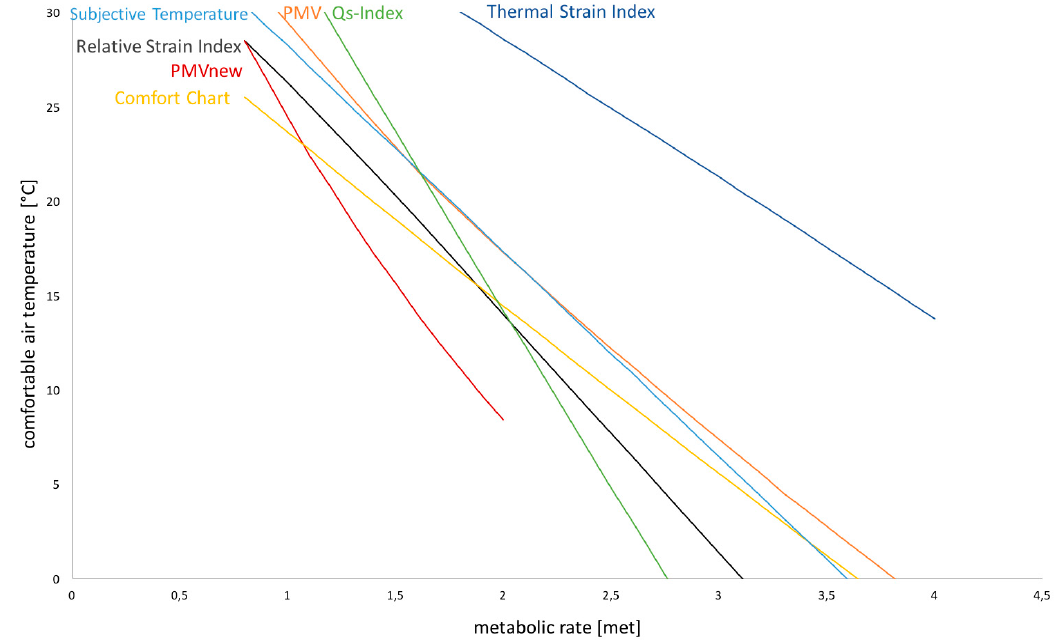
Figure 1. The comfortable room air temperature as a function of the metabolic rate (1 met = 58.2 W/m 2 ) and a clothing insulation of 0.5